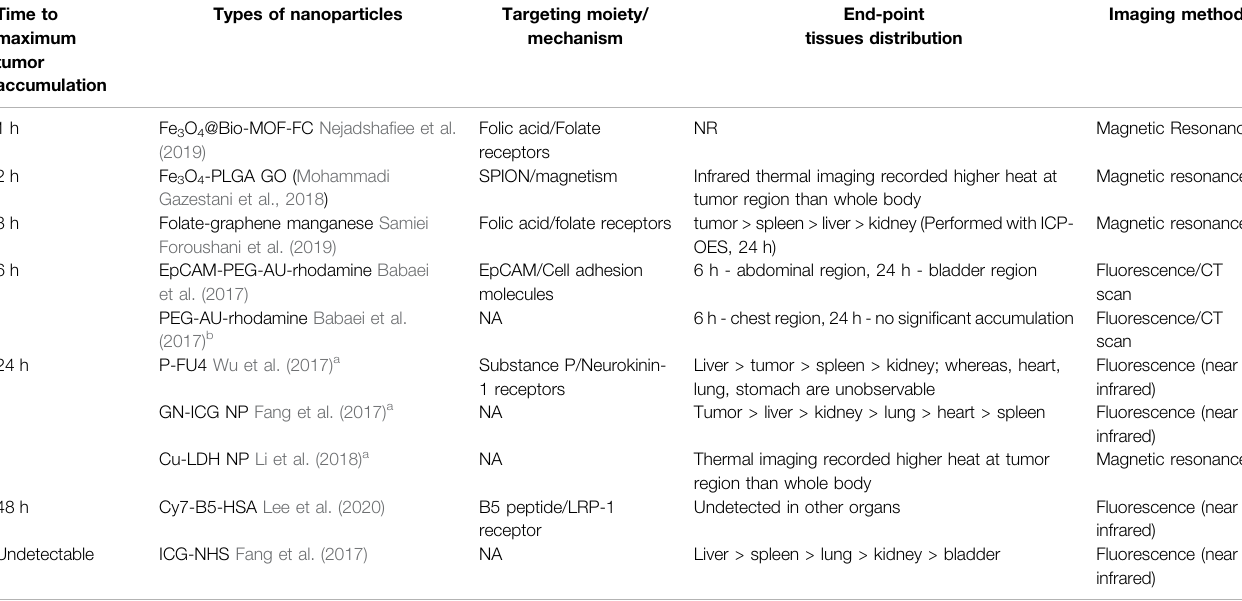
TABLE 3 | Relative time to achieve maximum tumor accumulation of 5FU encapsulated/conjugated nanotheranostics and their imaging techniques. Time to